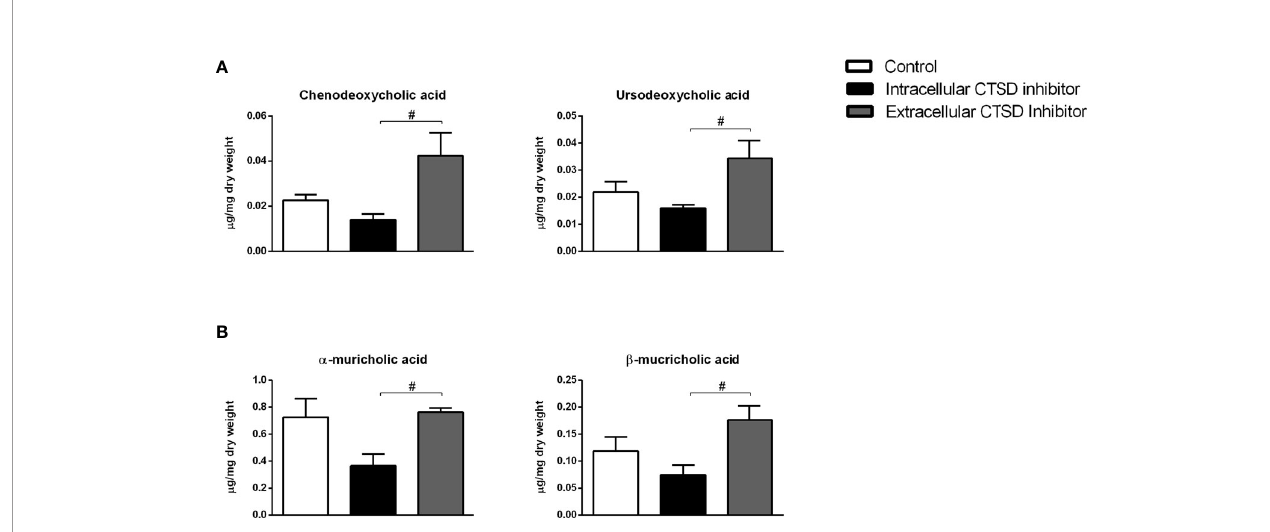
FIGURE 3 | Increased faecal bile acid levels upon extracellular CTSD inhibition in Ldlr-/- mice: (A) Faecal measurements of primary bile acids (B) Secondary bile acids in the faeces. Error bars represent ± SEM. n = 4 per group. # represents p < 0.05 compared to intracellular CTSD inhibitor- treated mice as determined by one-way